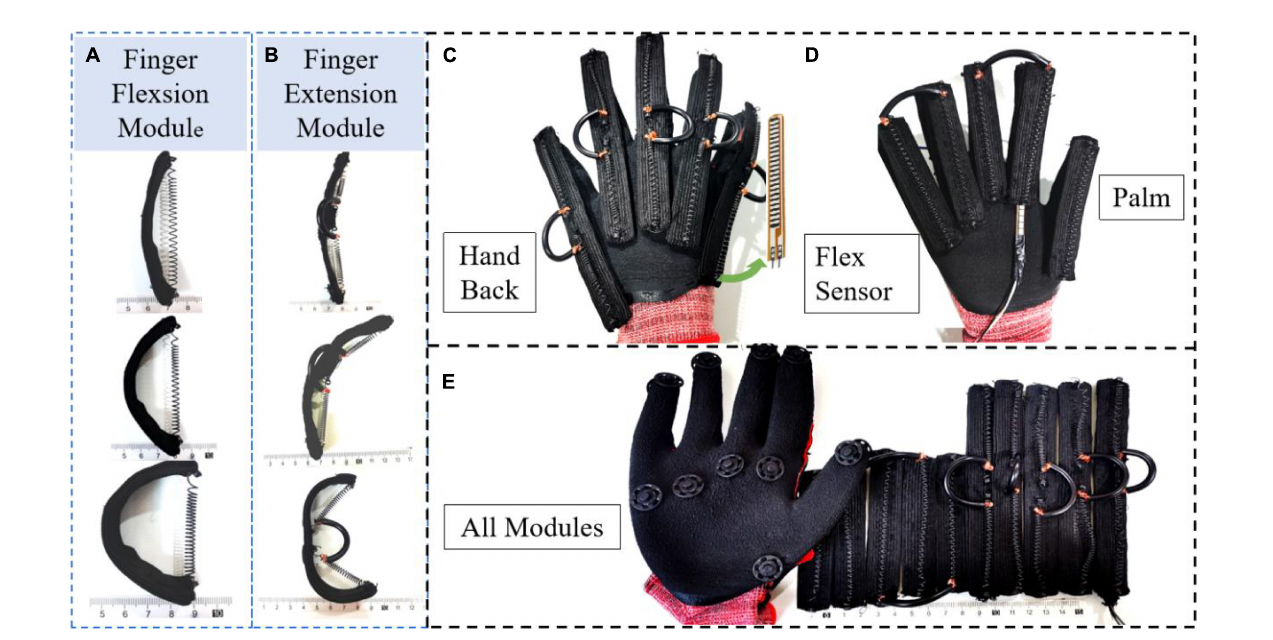
FIGURE3 Design of a soft hand exoskeleton actuated by SMA-based soft composite structure. (A,B) Finger flexion and extension modules; (C,D) the design of the back and palm of the soft hand exoskeleton; (E) the modular design of the soft hand exoskeleton.